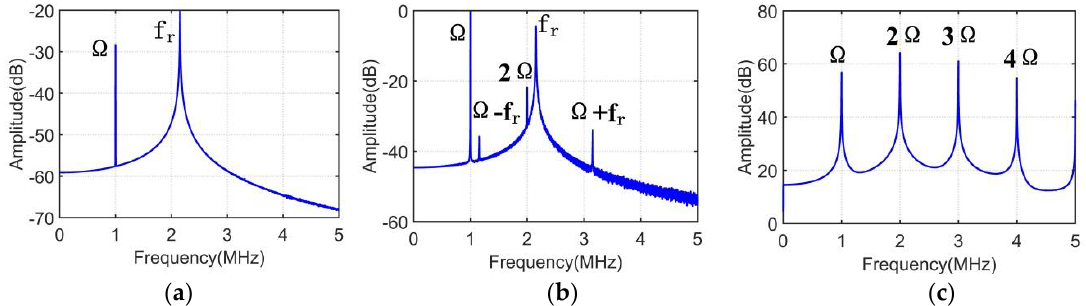
Figure 2. Numerical power spectrum of the Nd: YVO 4 laser with different feedback levels: ( a ) weak feedback, ( b ) moderate feedback, and ( c ) strong feedback.